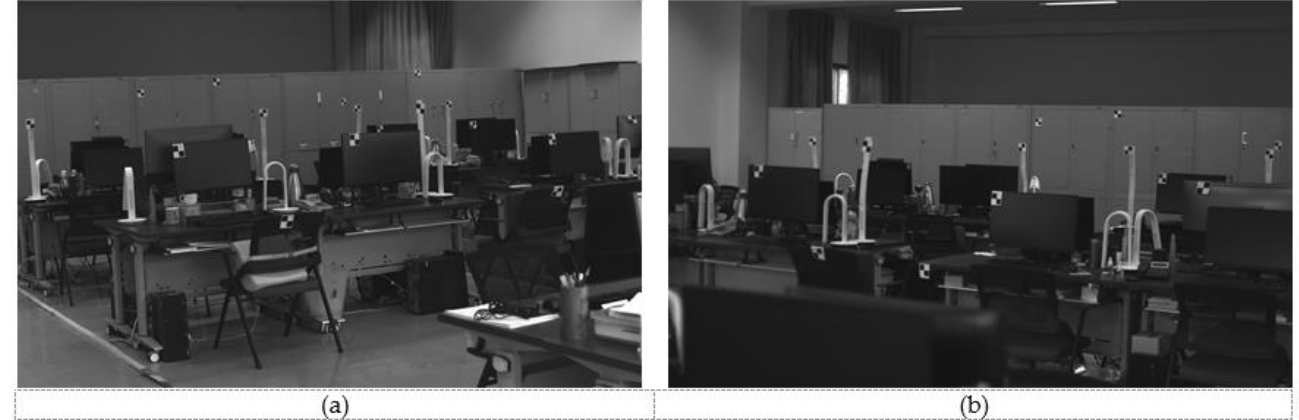
Figure 8. ( a ) Left camera . ( b ) Right camera.